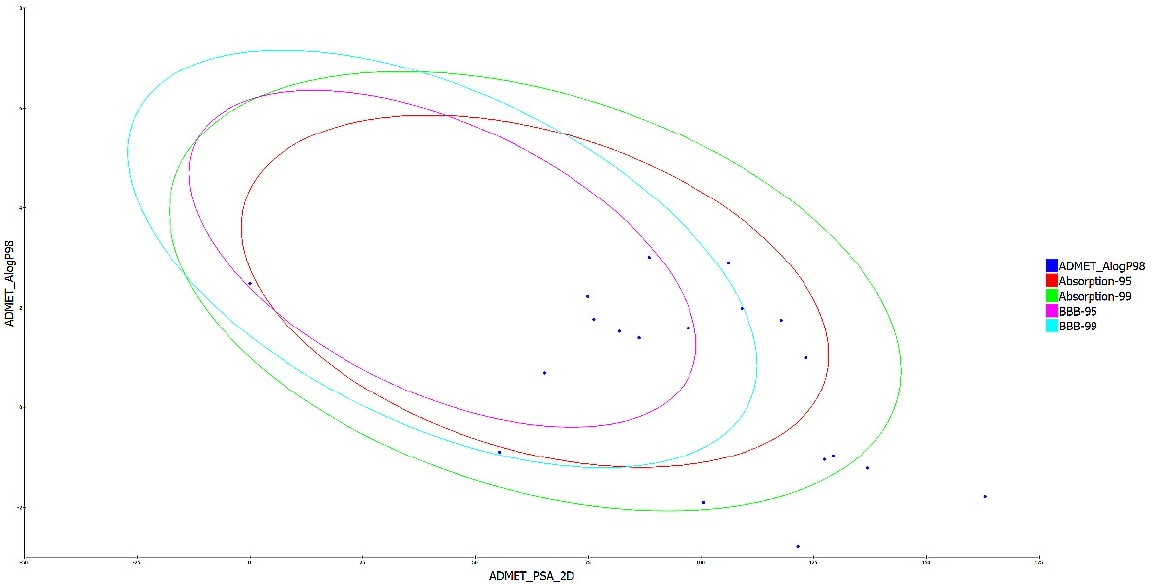
Figure 2. A plot of polar surface area (PSA) versus ALogP in ADMET analysis of filtered substances, with % and % confidence limit ellipses corresponding to the blood–brain barrier (BBB) and intestinal absorption, respectively. Table 3. Drug-likeness properties of the compounds.